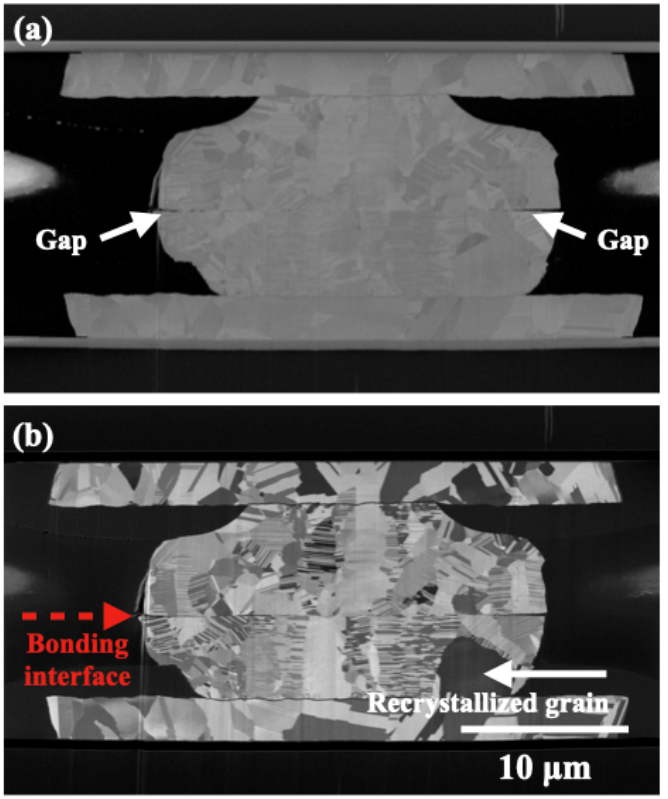
Figure 5. ( a ) Cross-sectional FIB electron ( b ) ion images of the microbumps bonded at 93 MPa/10 s under 300 °C.